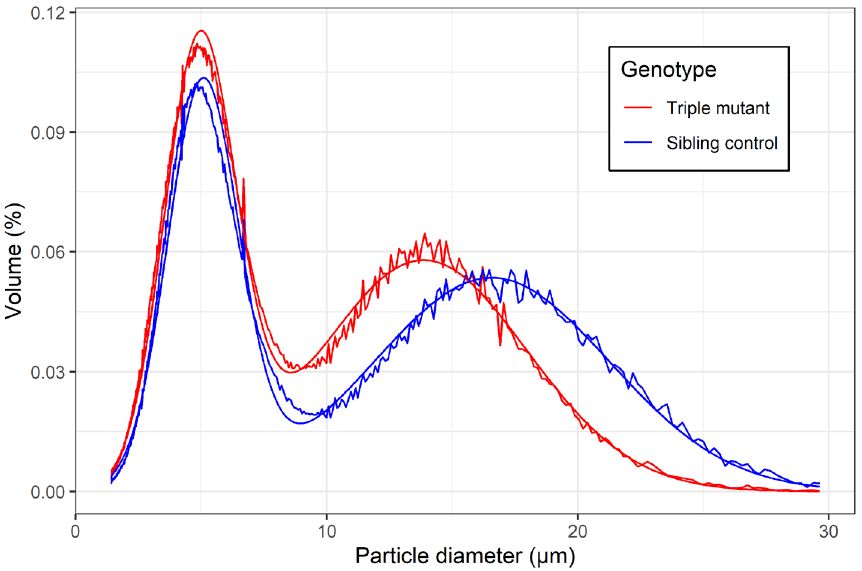
Figure 4. Starch granule size distribution of triple mutants ( ssIIIa -ABD) and sibling controls. Volume values represent the average observed proportion of volume accounted for by each particle diameter for n = 5 biological replicates per genotype, with average two-component normal mixture models for both genotypes overlaid.